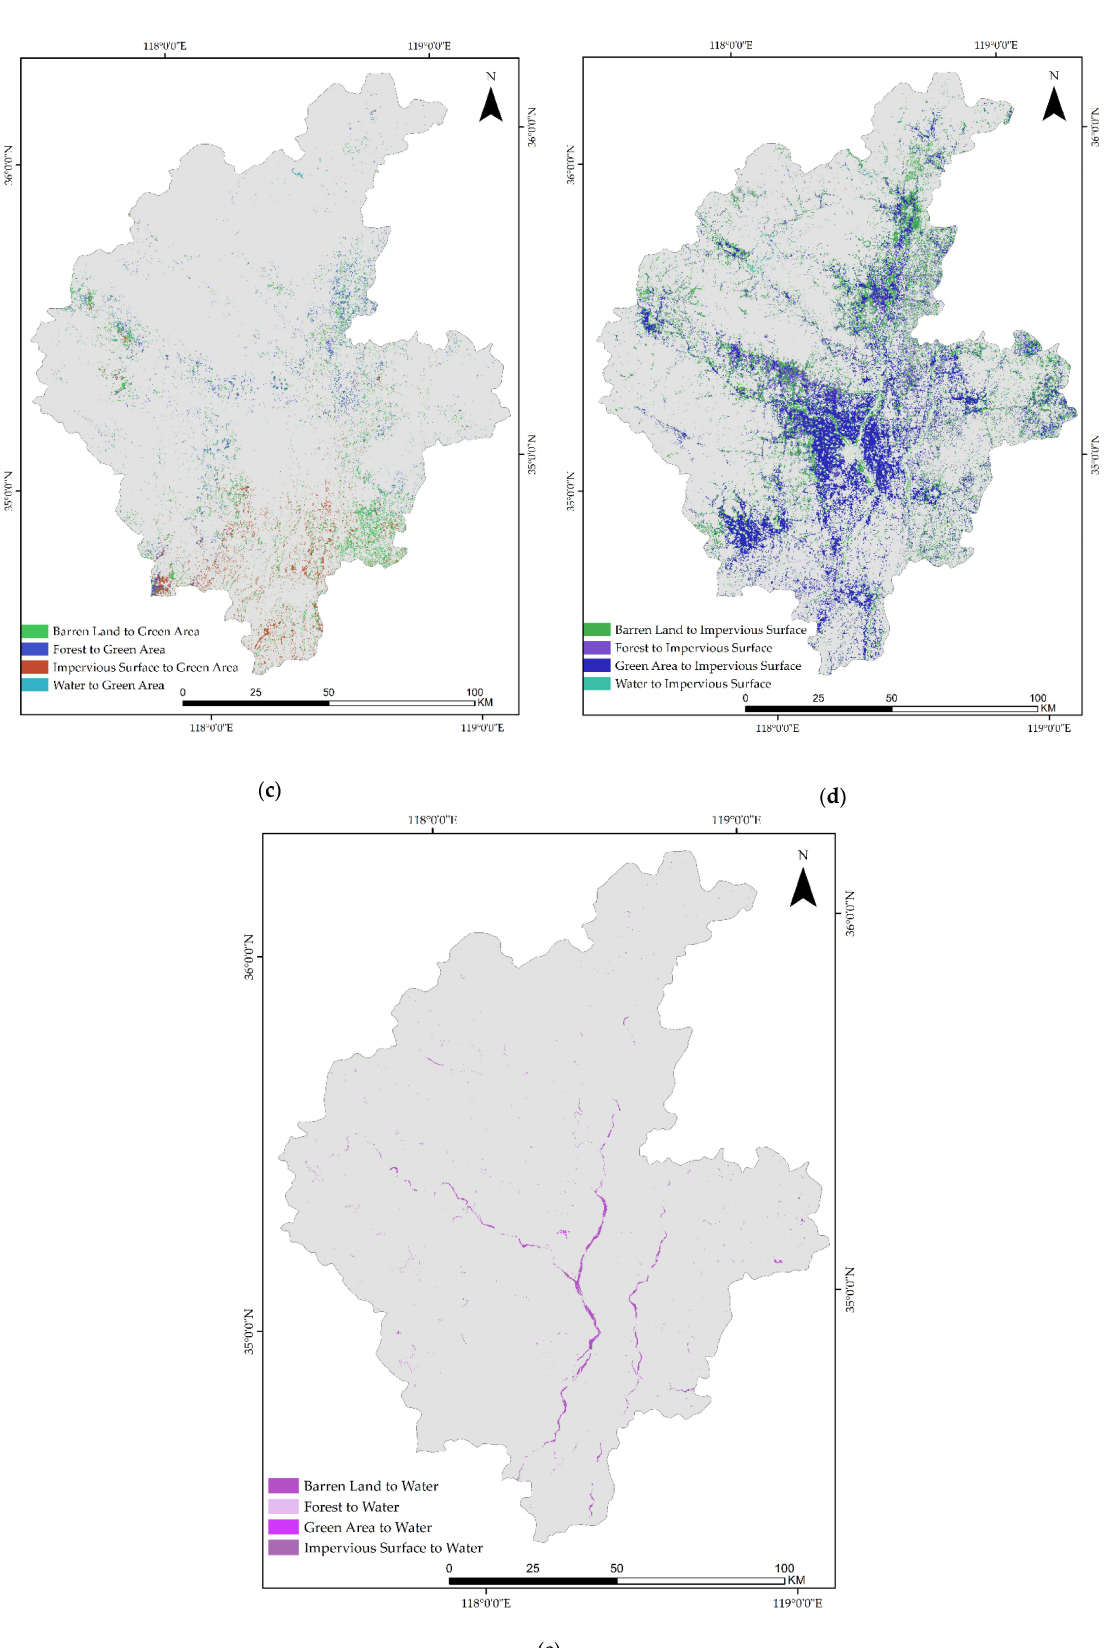
Figure 6. LULC transition in 1990–2020: ( a ) transition to barren land, ( b ) transition to forest, ( c ) tran- sition to green area, ( d ) transition to impervious surface, and ( e ) transition to